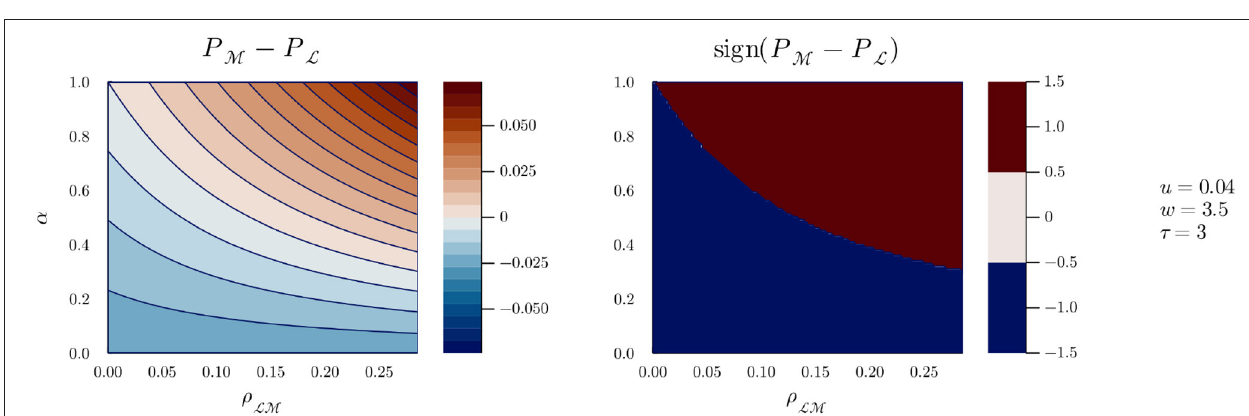
FIGURE 4 | g ( α , ρ LM ) for u = 0.04, w = 3.5, and τ = 3.